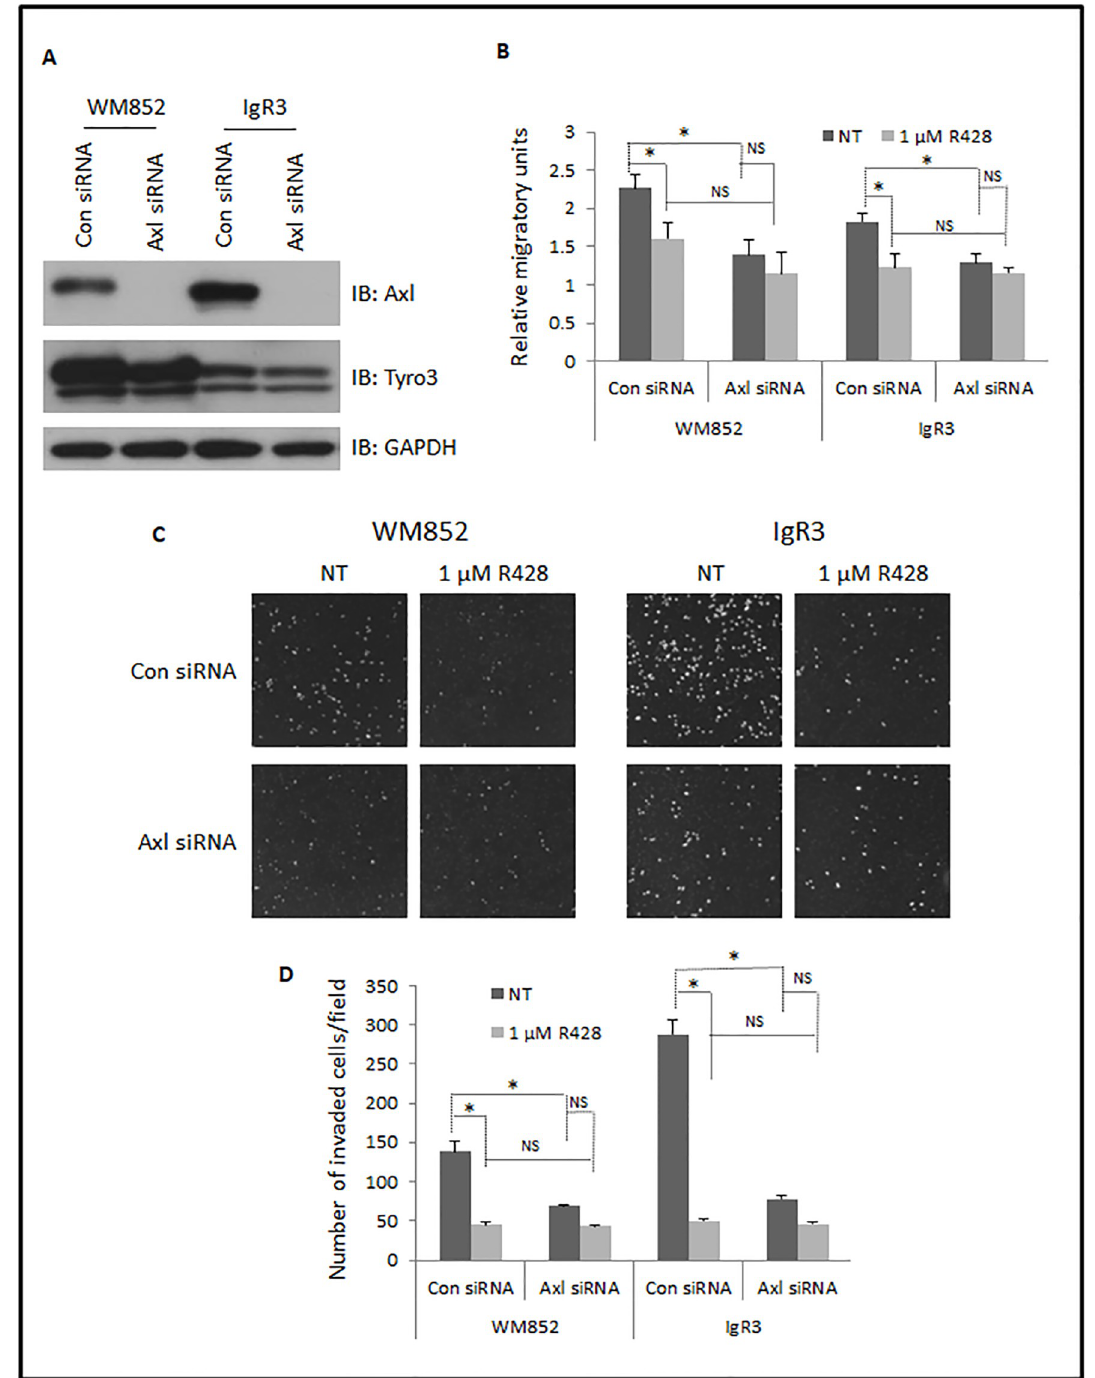
Fig 4. Transient silencing of Axl using siRNA reduces migration and invasion of melanoma cells. IgR3 and WM852 cells were transiently transfected with Axl siRNA for 48h. (A) Immunoblottings were performed using indicated antibodies to show selective downregulation of Axl. (B) Quantitative results of relative migratory speed of transfected cells with or without 1 μ M of R428 treatment. (C) Representative images of DAPI-stained cells invaded through MatriGel and retained on the bottom of transwell membrane. (D) Quantitative results of invaded cells. Shown are representative blots and pictographs of three experiments. Data are mean of ± SD of three independent experiments. Statistical analysis was performed using Student’s t-test. � P < 0.05, NS: not significant.